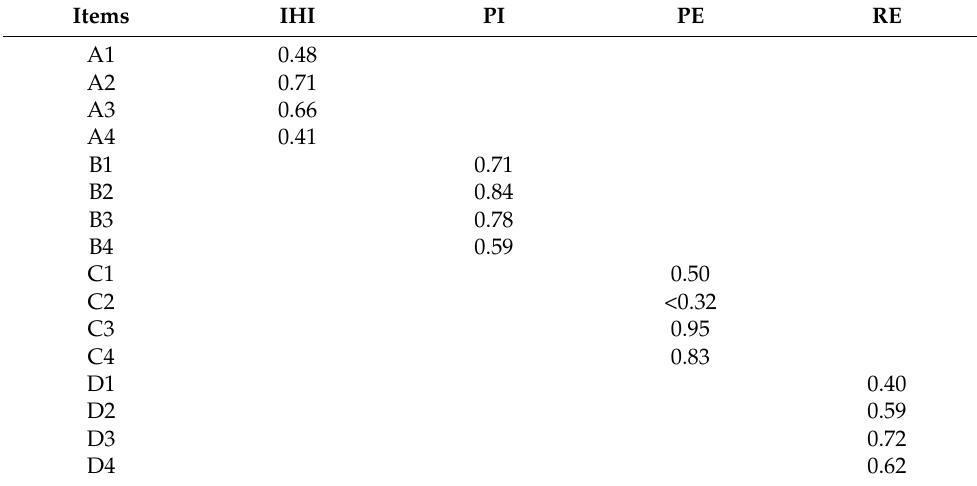
Table 1. Factor loading, eigenvalue and variance explained for the Chinese version of the DEFS.